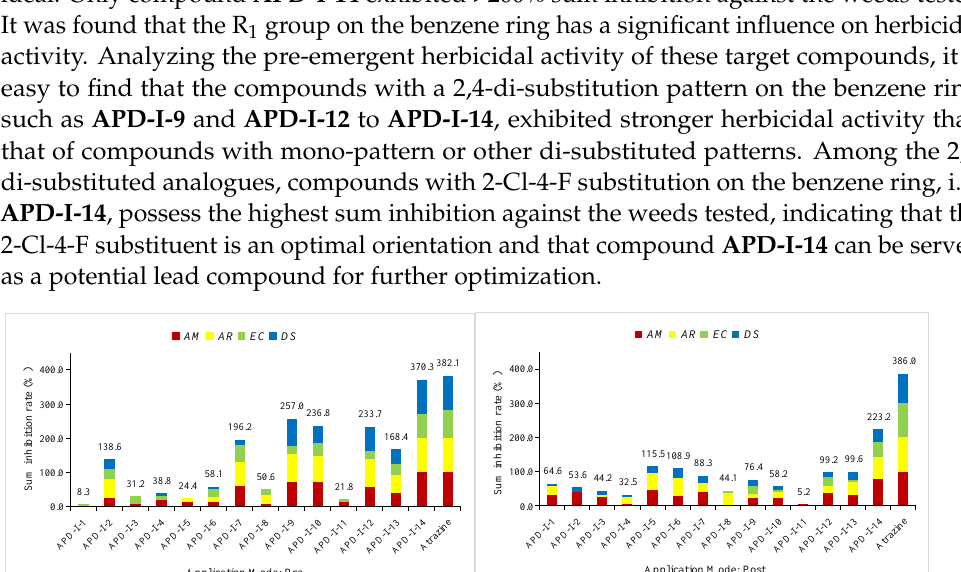
dosage of 1500 g ha −1 after treatment at 14 days (Pre) or 21 days (Post); Pre — pre-emergence condition; Post — post-emergence condition; Abutilon theophrasti Medicus (AM), Amaranthus retroflexus L. (AR), Echinochloa crus-galli (EC) and Digitaria sanguinalis (L.) Scop. (DS).